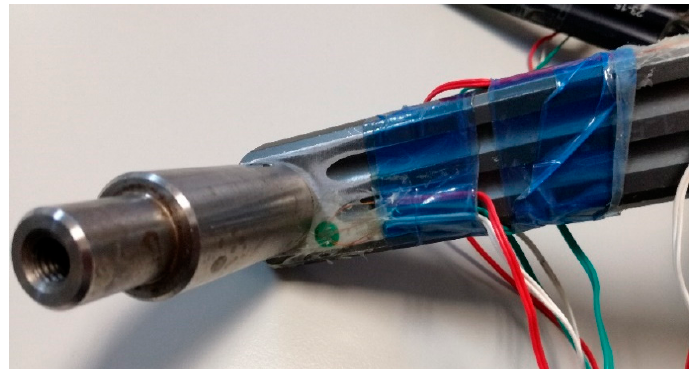
Figure 1. Position of the strain gauge rosette #1.